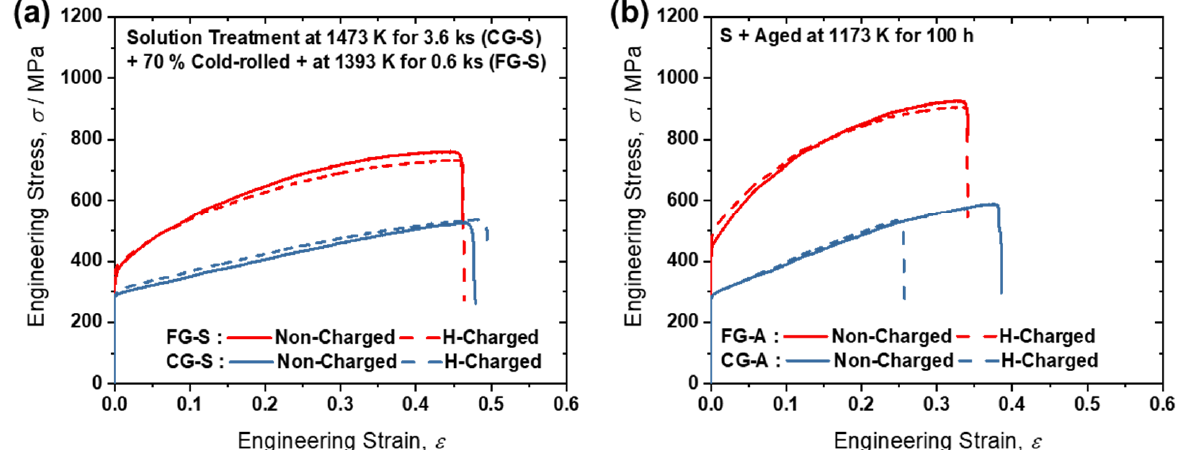
Figure 4. ( a ) Engineering stress–strain curves of ( a ) solution-treated (-S) and ( b ) aged (-A) specimens. The red and blue lines indicate FG- and CG- specimens, respectively. The solid and dotted lines mean the non-charged and the hydrogen-charged specimens, respectively.